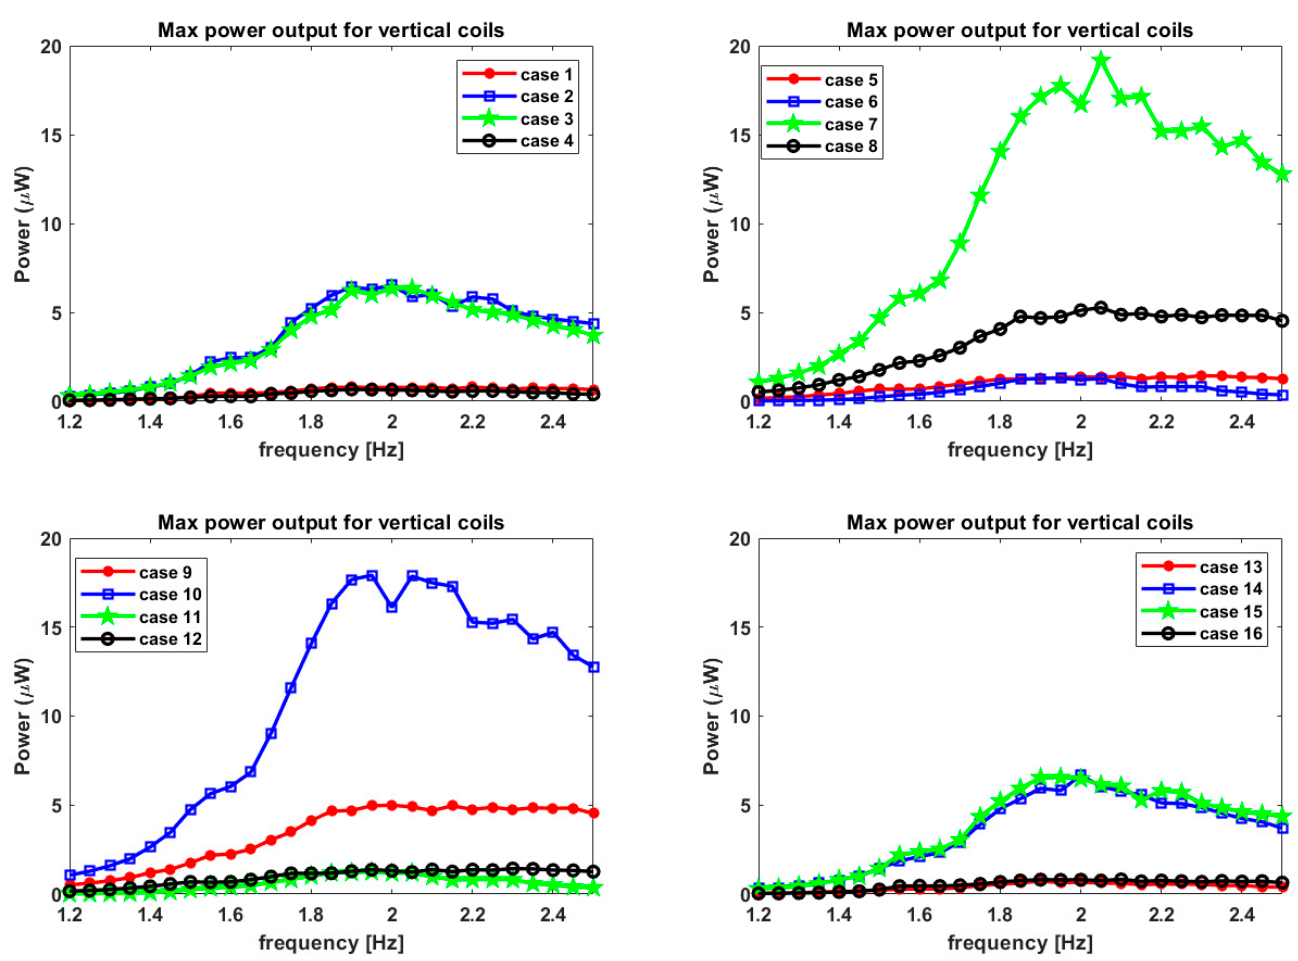
Figure 14. Maximum power output from the vertical coil for L = 10 cm tank.